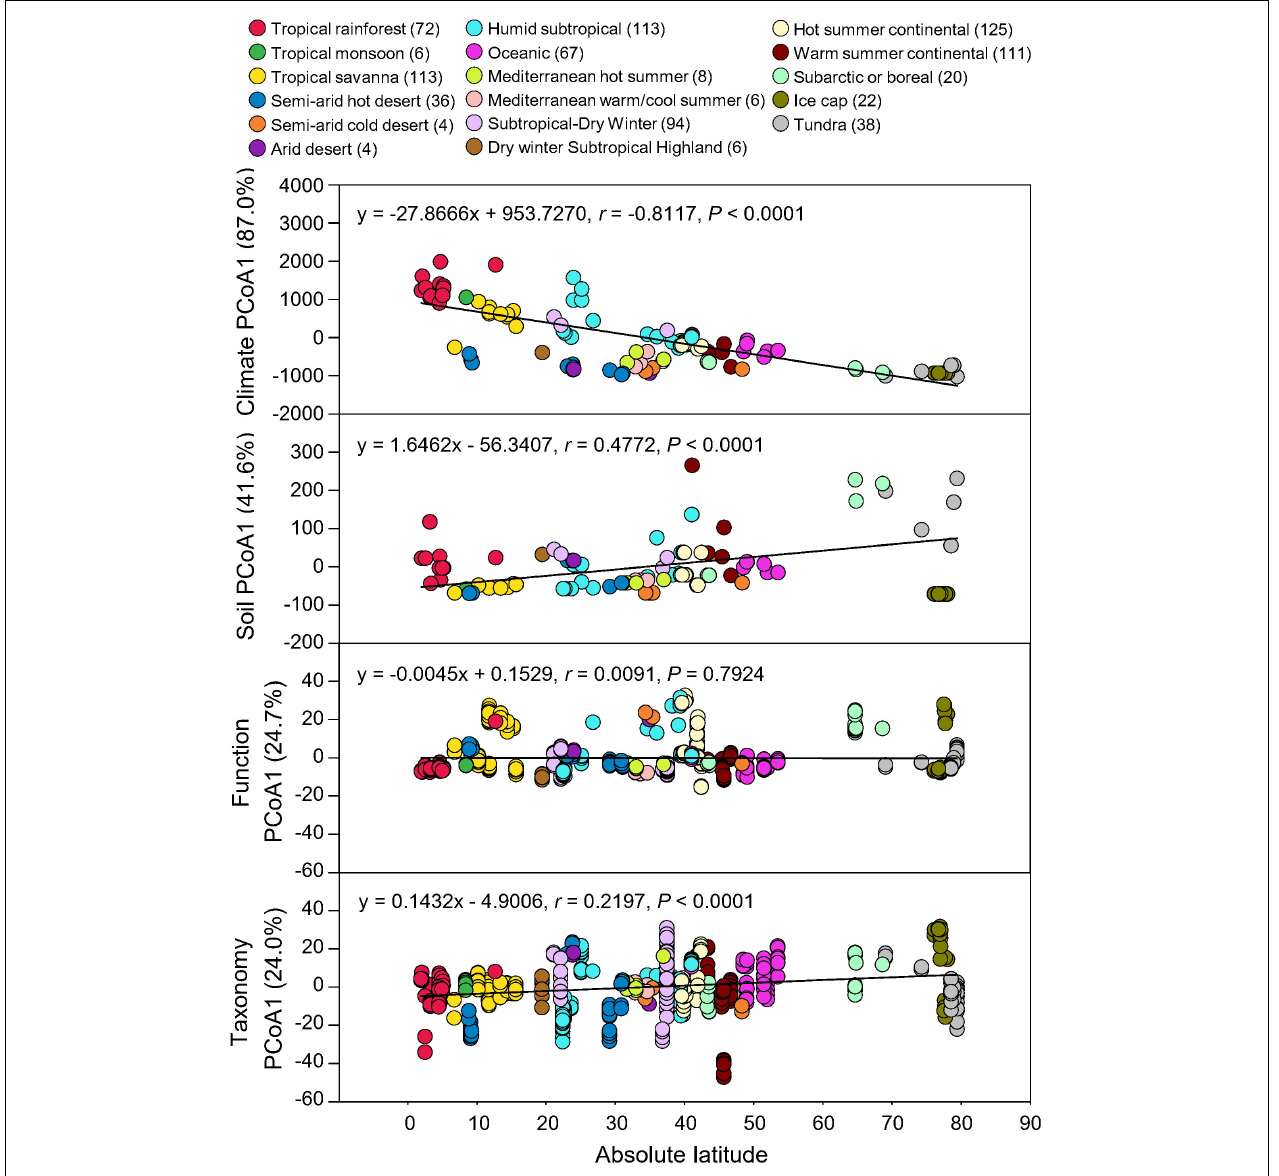
FIGURE 3 | Latitudinal distribution of functional and taxonomic diversities. Pearson’s correlations of the absolute latitude of soil metagenome locations with principal coordinate (PCoA) 1 scores of Euclidean distance of MAT and MAP data (Climate) and soil data of C, pH, sand, silt, and clay (Soil), Bray-curtis similarity of soil metagenomes annotated in the SEED Subsystems database at Level 3 (Function) and RefSeq database at genus level (Taxonomy) grouped by 17 climate zones. Variation explained by principal coordinate dimension is given in parentheses by percentage. Sample sizes of each climate zone classification are given in parentheses. Regression equations, coefficients ( r ), and P -values are